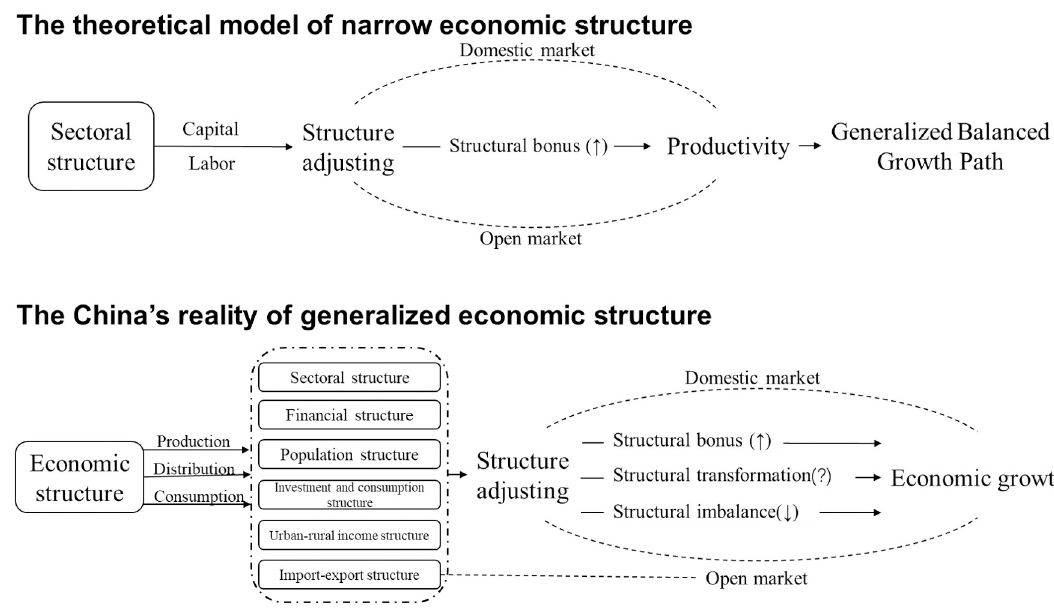
Fig 3. The framework of structural relationship